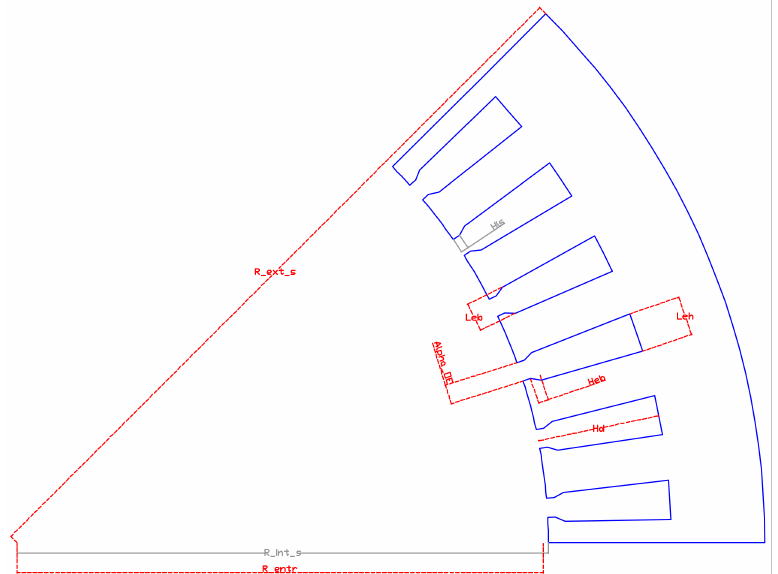
Figure 5. Stator geometry parameters.